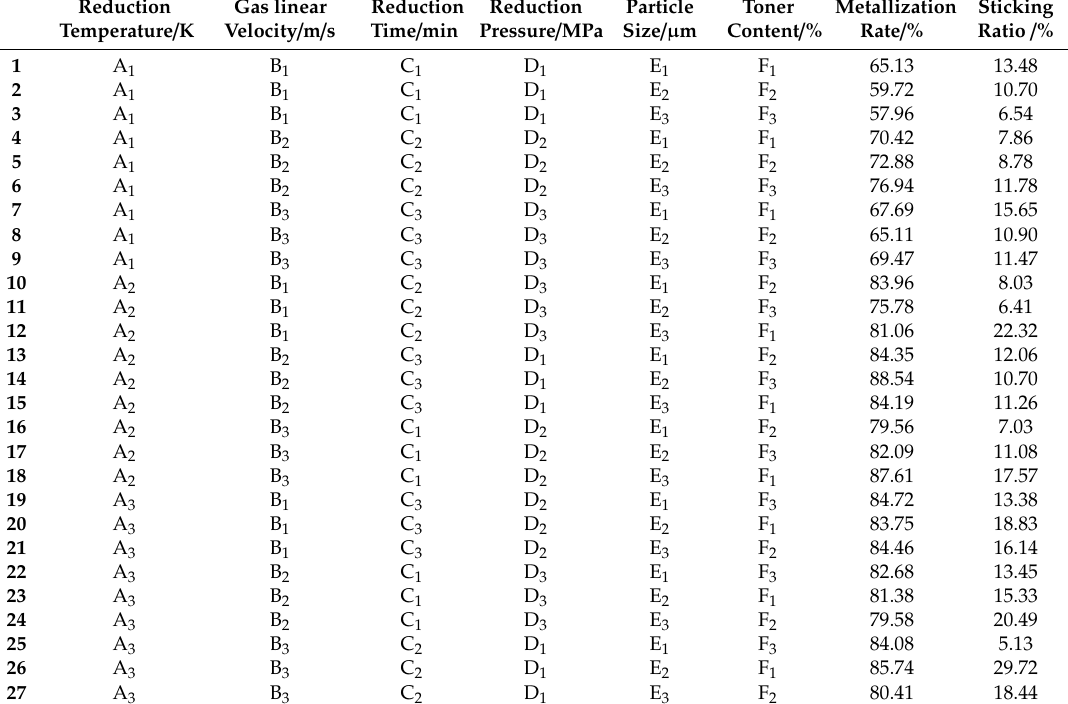
Table 6. Experimental scheme and results.